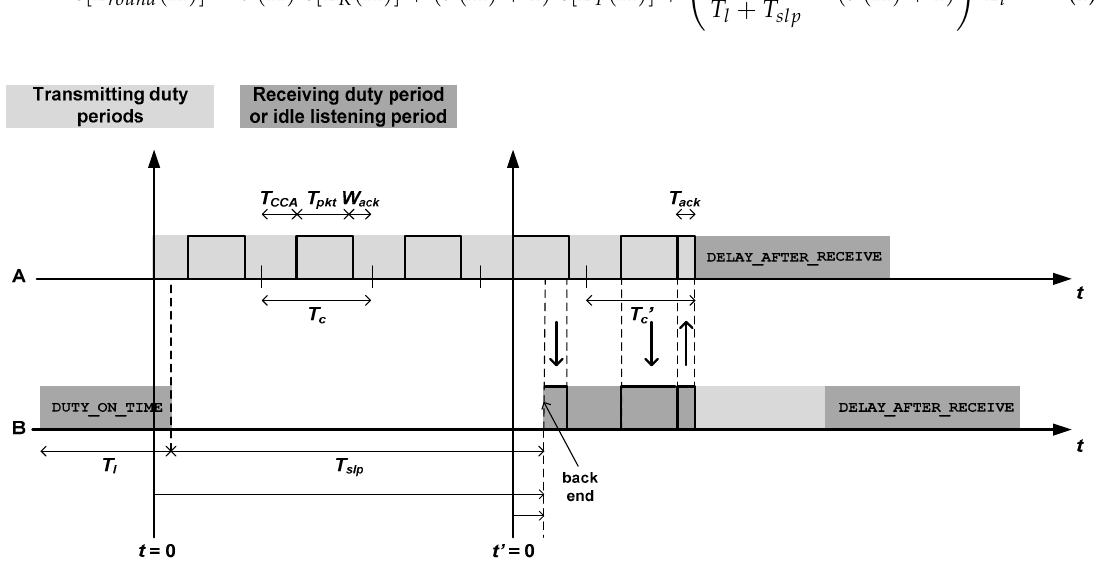
Figure 2. Operation of Low Power Listening (LPL) in TinyOS sensor nodes: Node A transmits a packet to node B, which receives and forwards this packet.